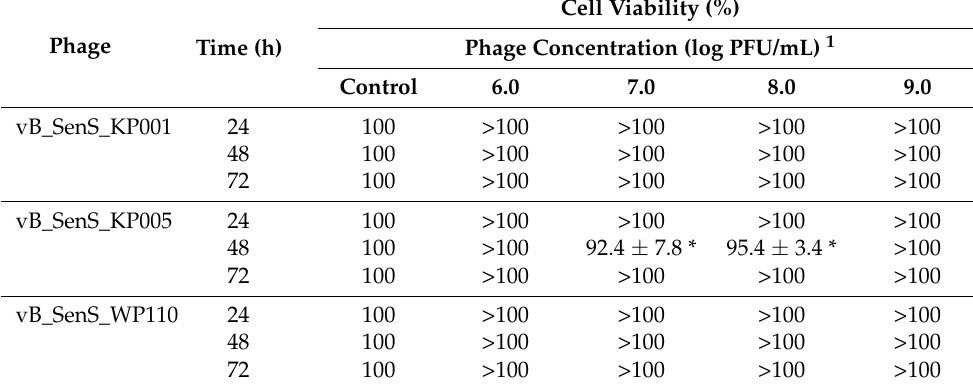
Table 4. Cell viability (%) of human dermal fibroblasts after treatment with a single phage.